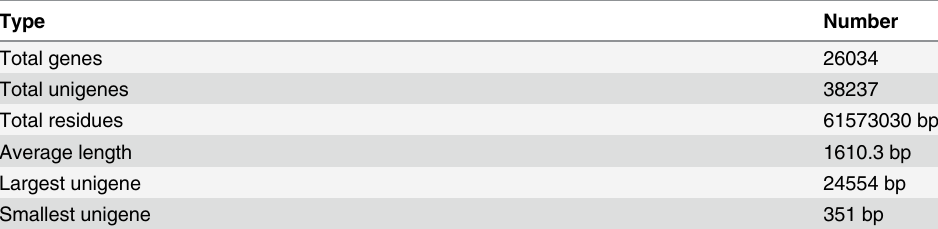
Note: Q20 indicates that every 100 bp of sequencing reads will have an error, and Q30 indicates that every 1000 bp of sequencing reads will have an